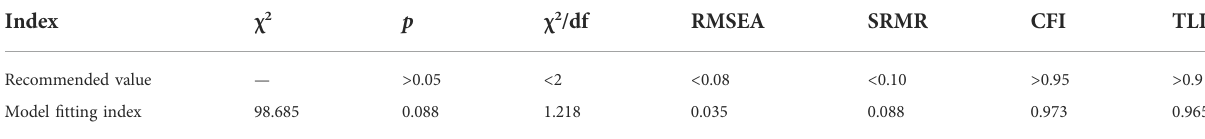
TABLE 1 Model fi tting indexes.